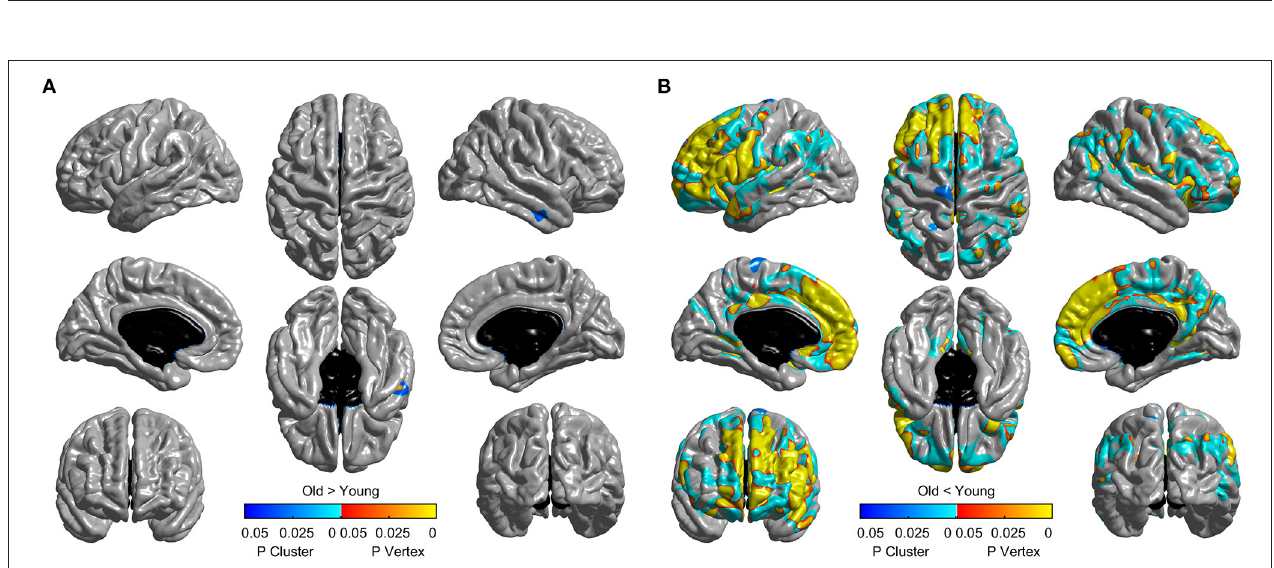
FIGURE 8 | Thresholded statistical map using random field theory implemented in Surfstat. It tests the effect of “Old > Young” (A) and “Old < Young” (B) separately. Brain areas with warm/cool color survived vertex/cluster-level random field theory correction. The default cluster-forming threshold was p < 0.001.